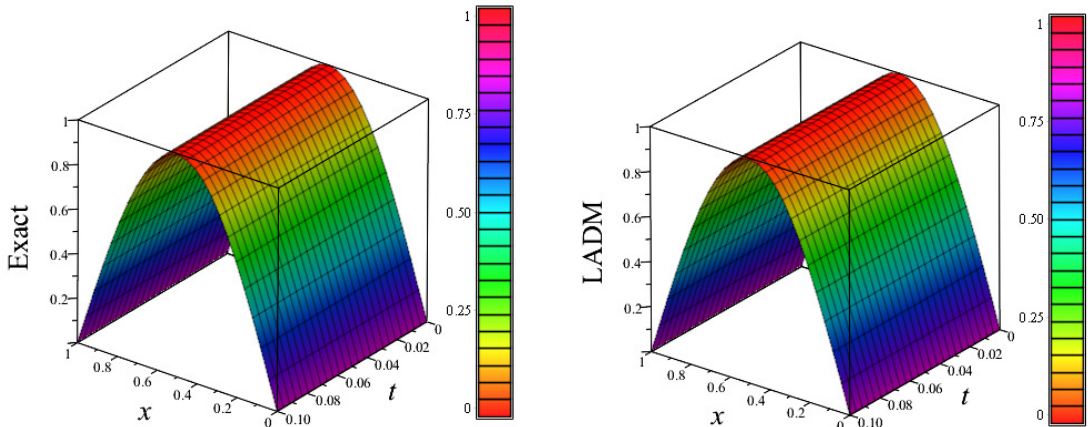
Figure 6. 3D plots of exact solution and approximate solution using LADM, vs. x vs. t , for numerical experiment